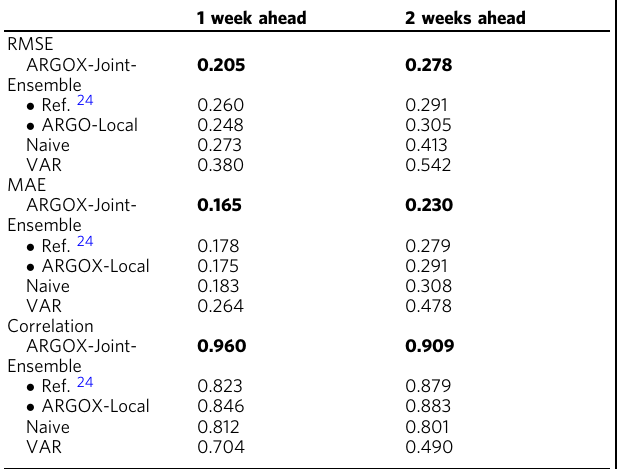
Table 5 Comparison of different methods for state-level % ILI 1 and 2 weeks ahead forecasts in 51 U.S. states.